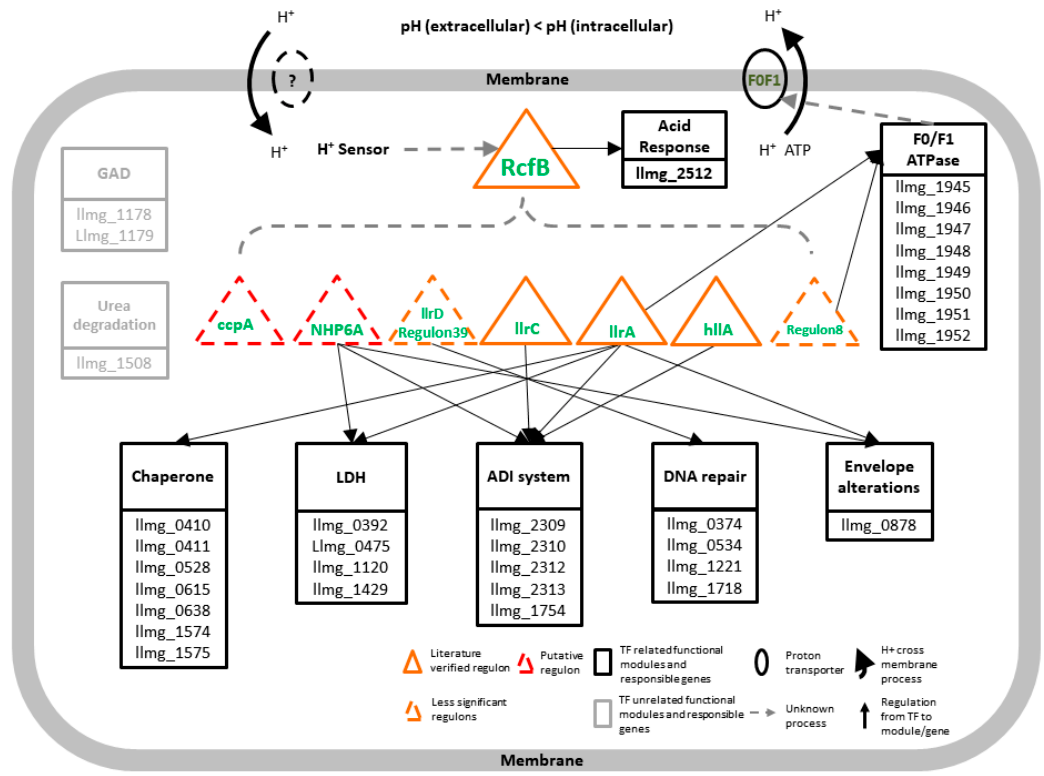
Figure 3. A working model of the transcriptional gene regulatory network in response to pH change in L. lactis . The mechanism is activated by the change of proton signal in a cell. Regulon RcfB is assumed to be the overall activator for the rest seven regulons and controls the ASR functional module solely. Three kinds of literature were verified; significant ASR-related regulons, llrA , llrC , and hllA , and two insufficiently significant regulons, llrD (regulon #39) and regulon #8 (llmg_1803) were predicted via our workflow but with results under a 0.8 motif similarity cutoff or a hit could not be found; one putative significant regulon NHP6A controls the seven functional modules which are experimentally verified in the close species MG1363. The other significant regulon ccpA failed to be confirmed by any literature-proved genes or transporters. Two extra functional modules, GAD, and urea degradation show no direct connection to all seven of the regulons. One or more homology genes are found in MG1363 for all the nine modules using BLAST. The solid arrows indicate regulation between regulons/TFs and functional modules/genes, and the dashed arrows indicate uncertain control processes. Additionally, two ovals indicate two trans-membrane proteins; one is confirmed as F0/F1ATPase and the other one, with the dashed line, whose related information we cannot find in the public-domain literature.